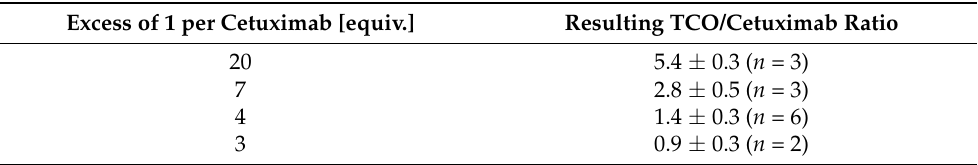
Table 1. Summary of the results of the systematic investigation of the derivatization efficiency of cetuximab using different excesses of ( E )-cyclooct-4-en-NHS carbonate ( 1 ). Excess of 1 per Cetuximab